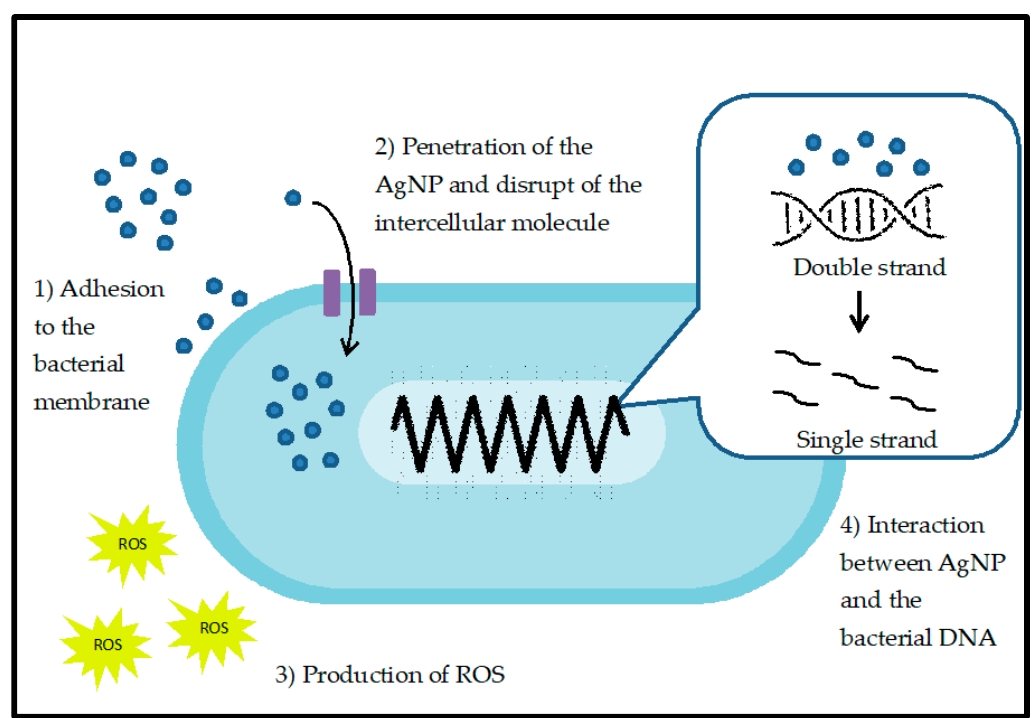
Figure 2. Antibacterial activities of silver nanoparticles.